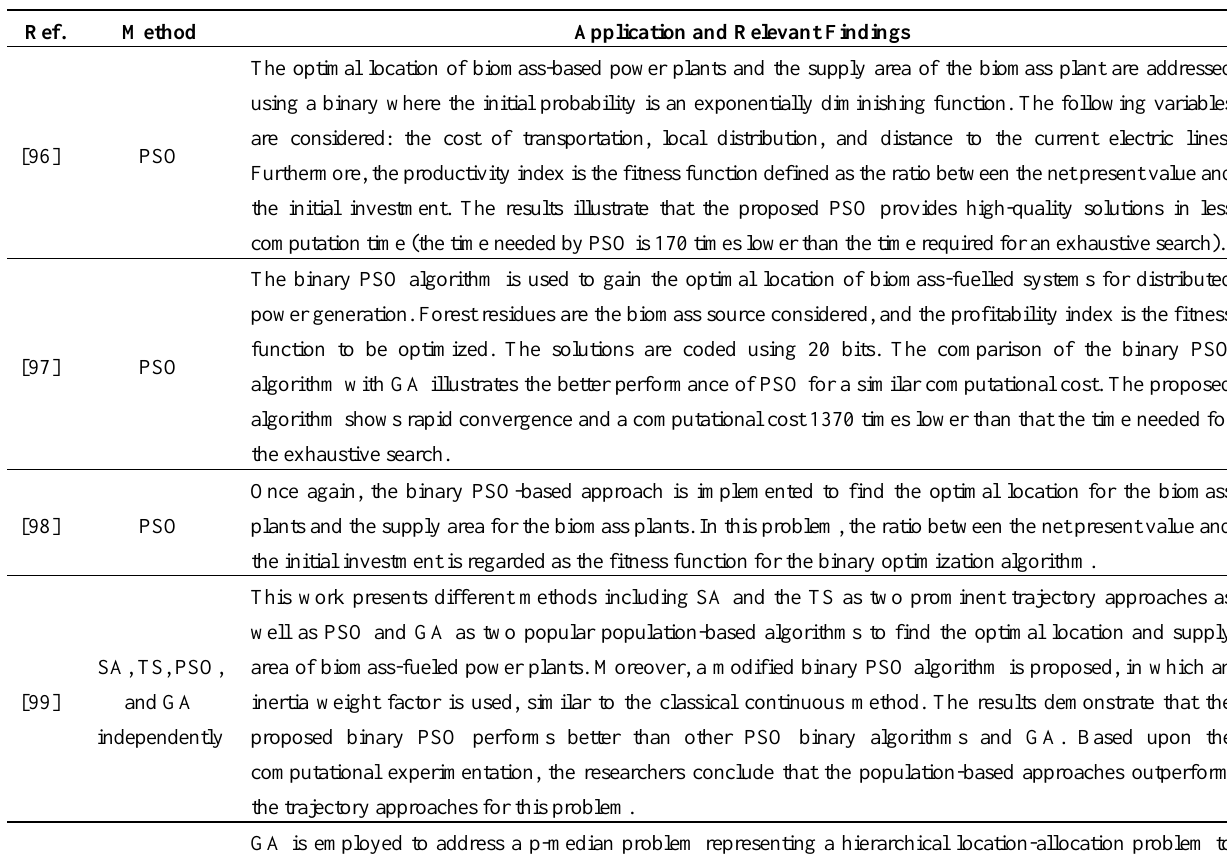
Table 10. Reviewed articles in the facility location